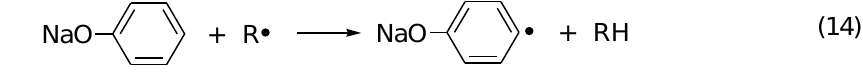
+ RNaO Scheme 3. The dependence of lifetime of phenolate intermediate on the reactivity of abstracting radicals.